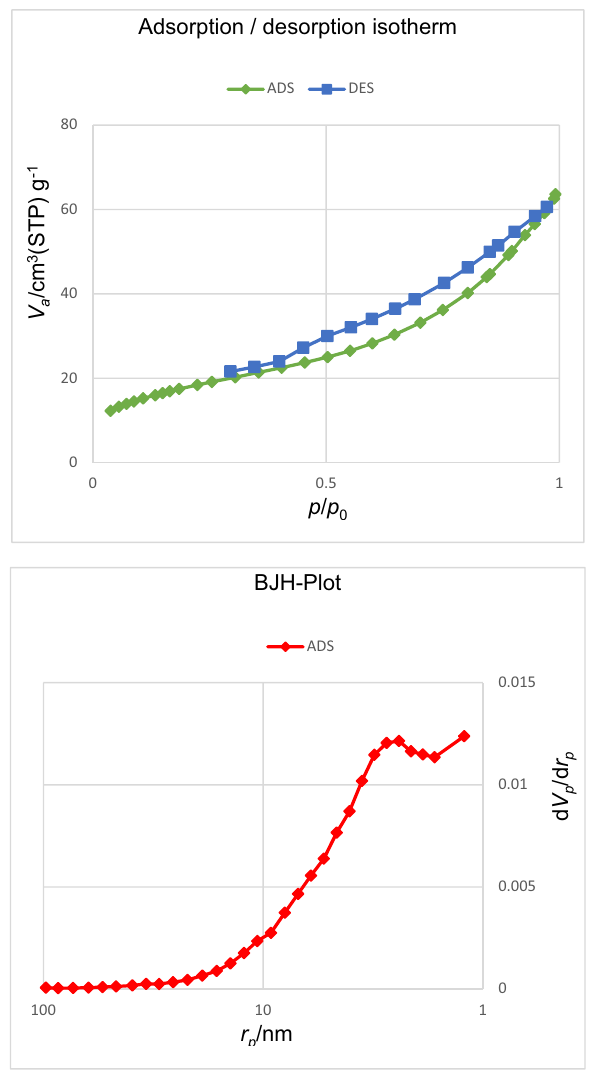
Figure 8. N 2 adsorption/desorption isotherms and BJH-Plot of the nanoporous Zn-MOF